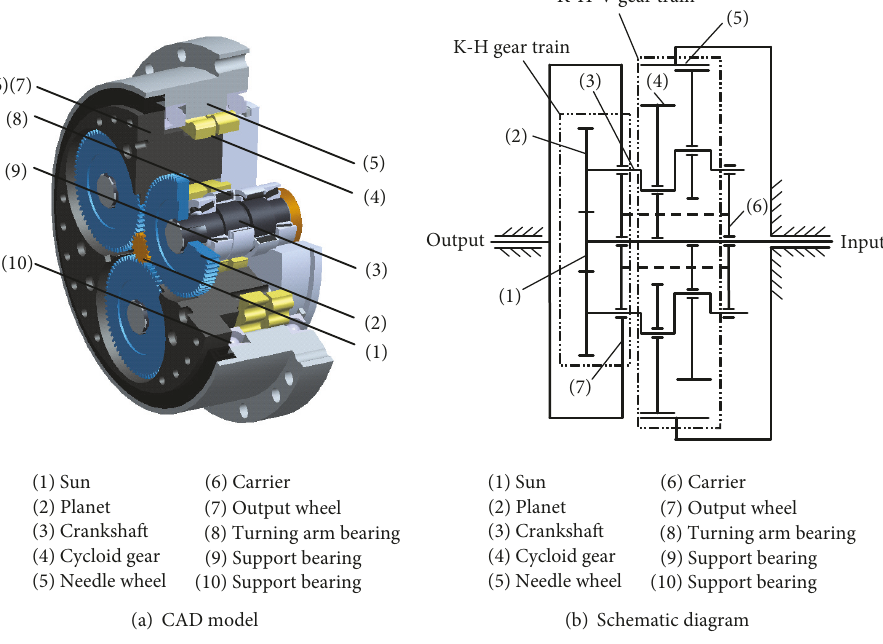
Figure 1: Schematic of RV